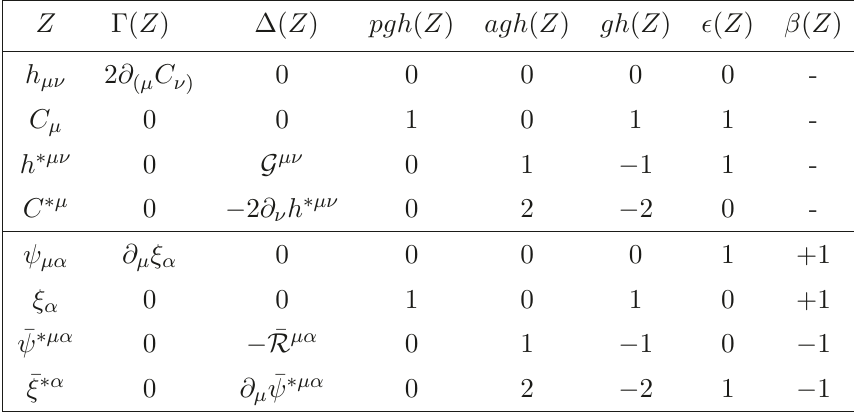
Table 1 . Properties of the Fields & Antifields ( s = 5 /